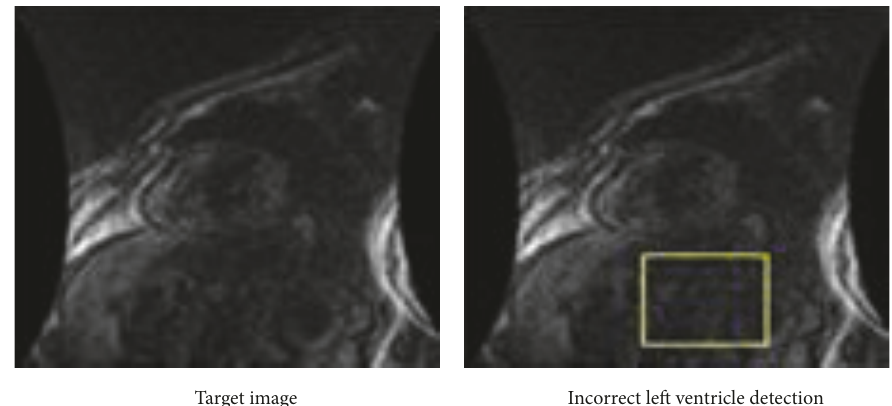
Figure 10: Wrong detection outcome using the developed system (fast spin echo sequence, FSE).